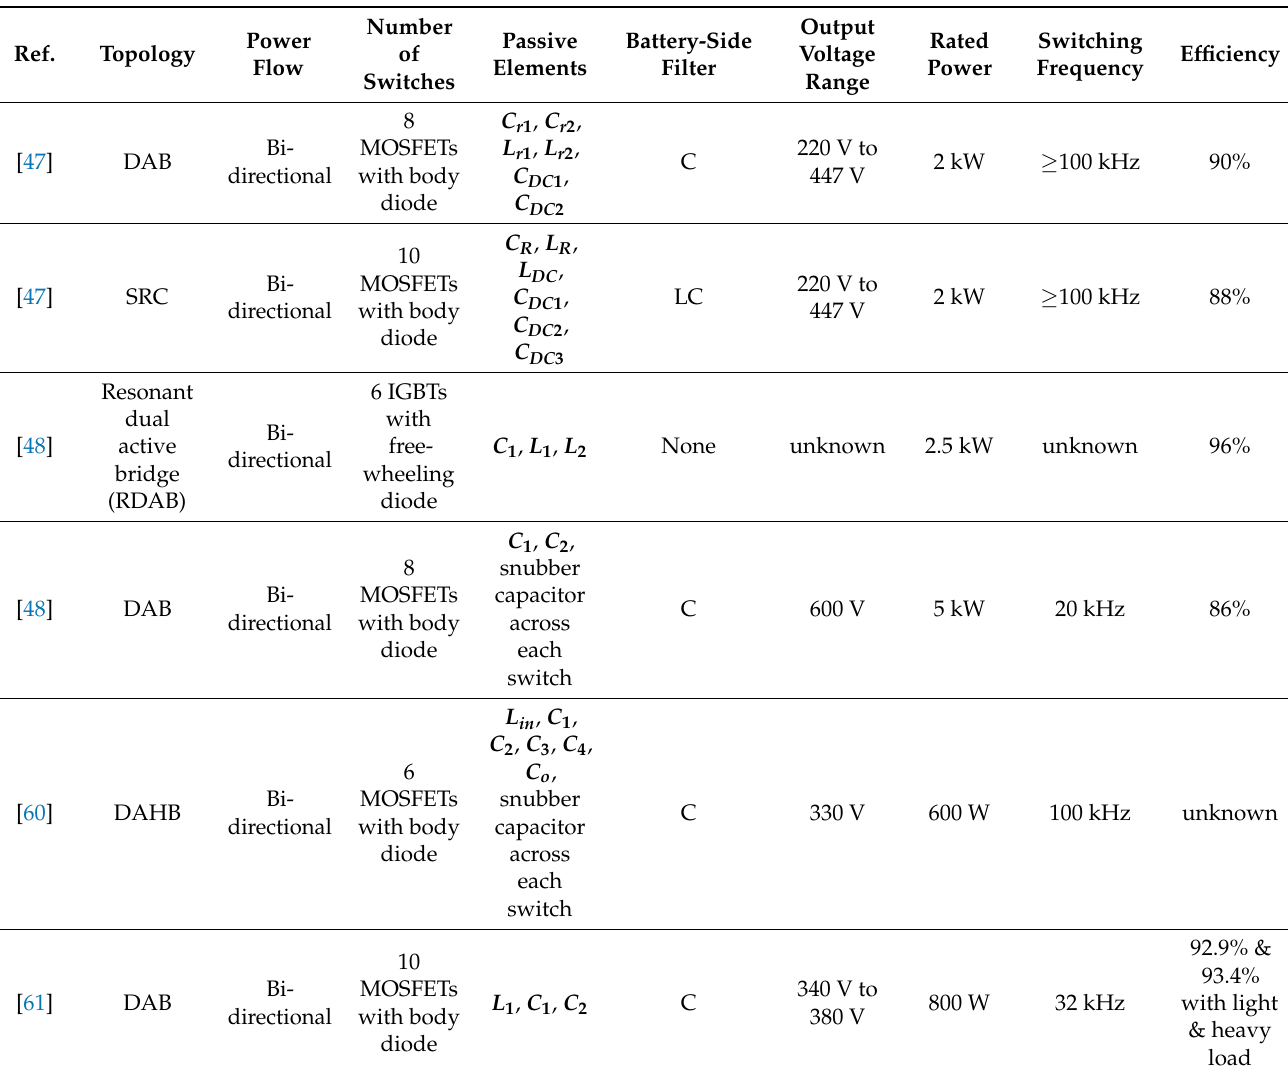
Table 2. Comparisons of various topologies for DC-DC stages.